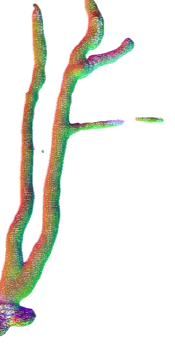
Figure 4. Generated polygon mesh of trunk